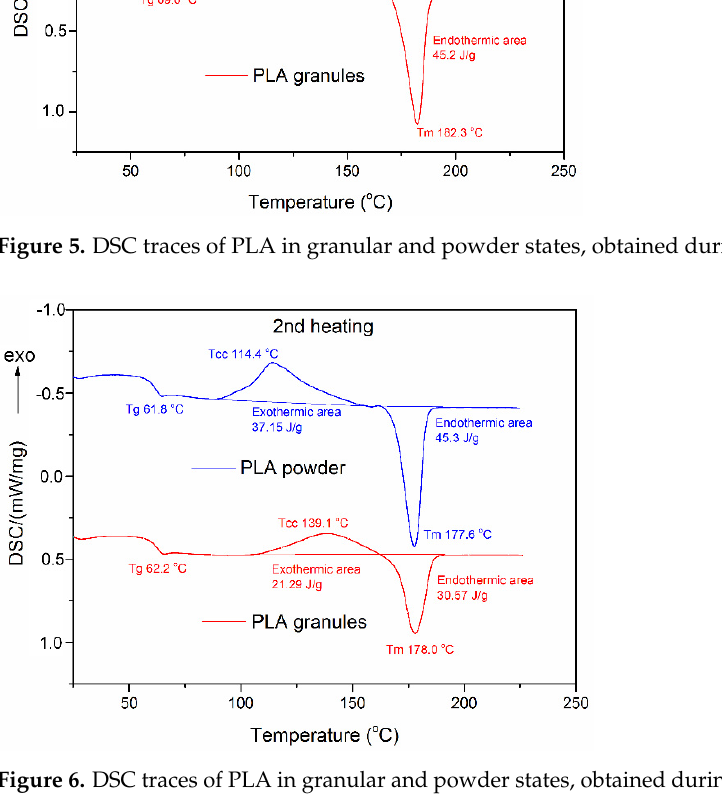
Table 4. Summary of DSC results obtained during two scans of every scan .